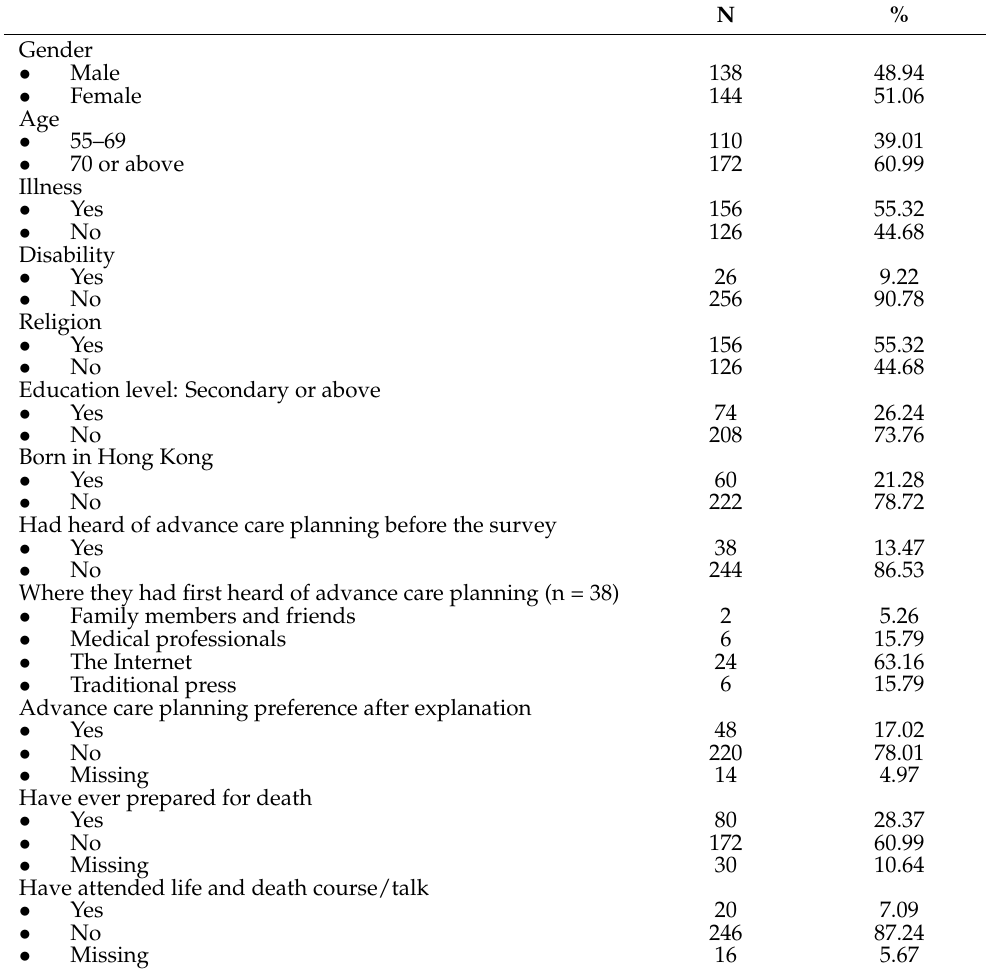
Table 1. Characteristics of the study population (N = 282).